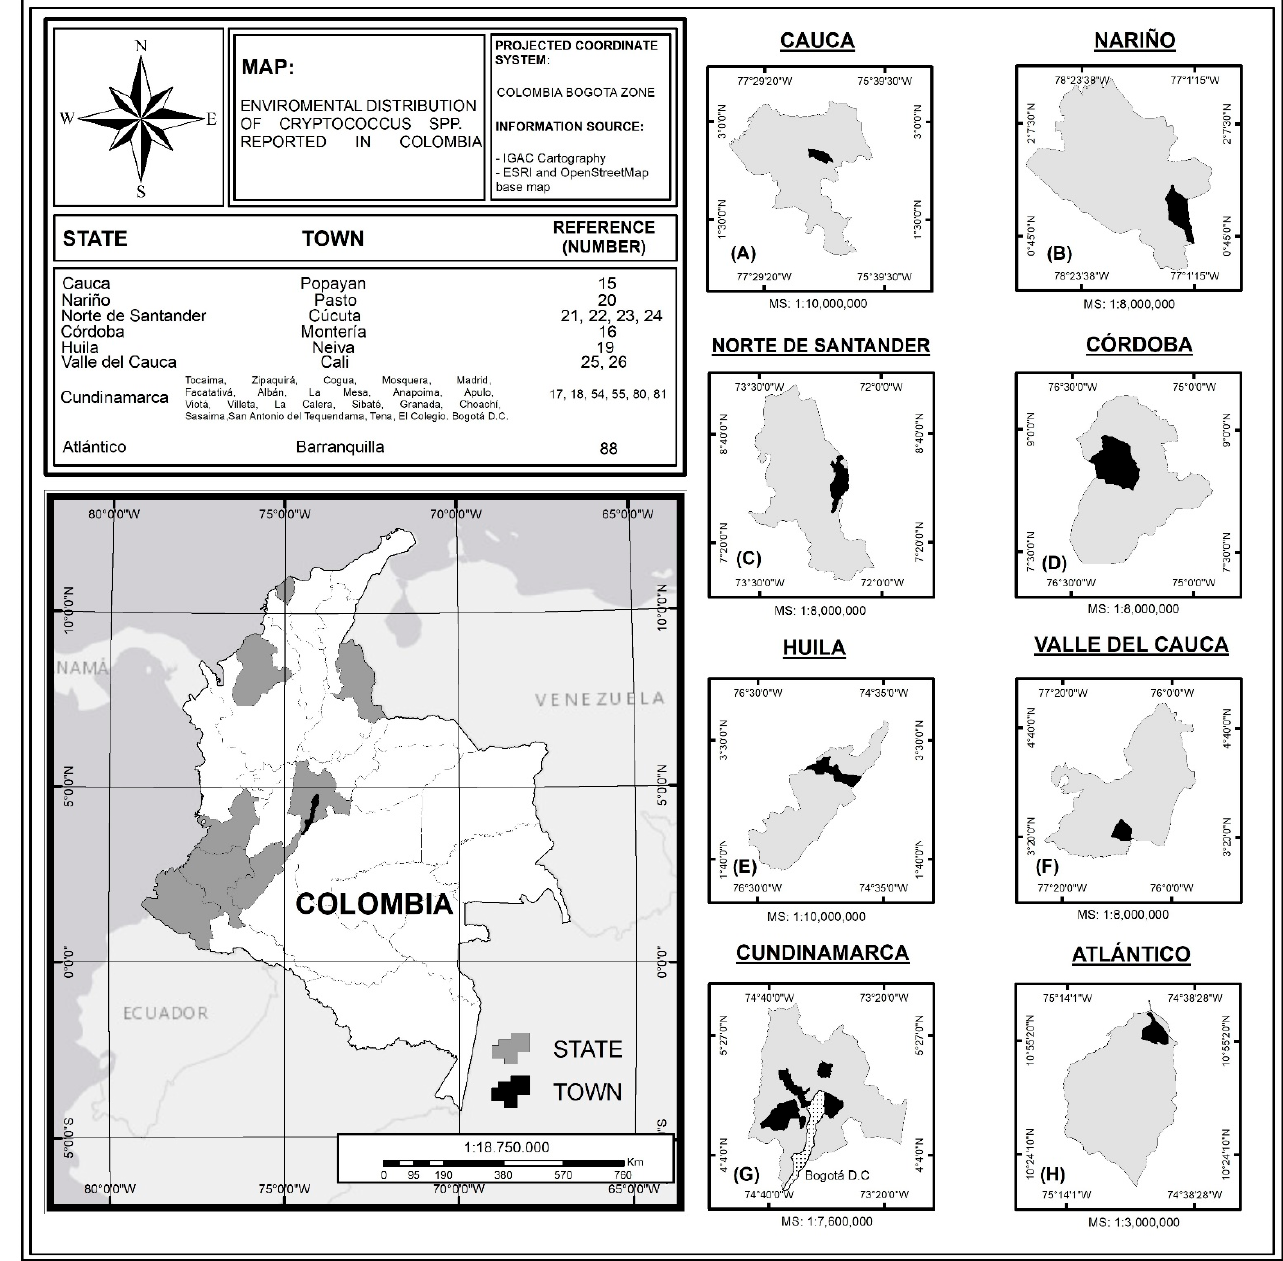
Figure 1. Distribution of environmental isolations of Cryptococcus spp. in Colombia; MS: Map Scale. ( A ) Department of Cauca, ( B ) Department of Nariño, ( C ) Department of Norte de Santander, ( D ) Department of Córdoba, ( E ) Department of Huila, ( F ) Department of Valle del Cauca, ( G ) Department of Cundinamarca, and ( H ) Department of Atlántico. Source: The authors of this study, based on the information recorded in Table 1.